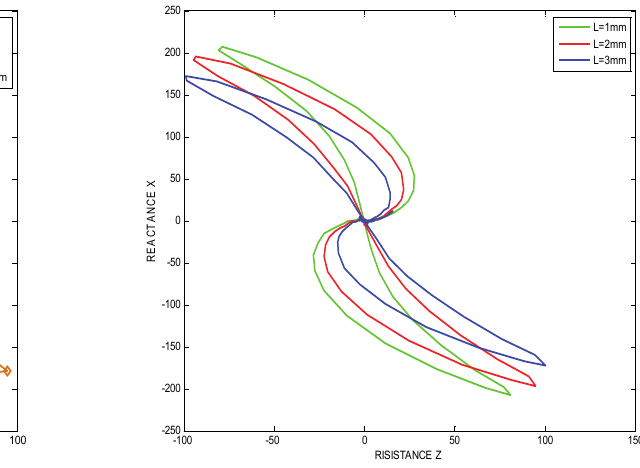
Figure 13: Evaluation of resistance and reactance sensor vs. crack depth.